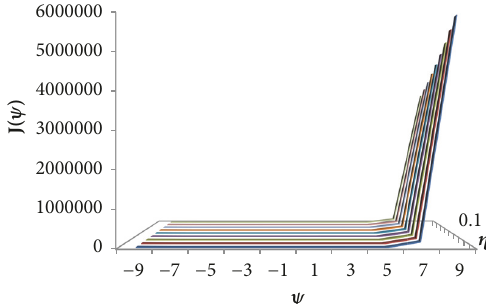
Figure 7: Graph of expected present value of the utility of asset 𝐽(𝜓) versus control 𝜓 and interest rate of liability 𝜔 while subjective discount rate 𝜂 and degree of relative risk 𝜆 are fixed at 0.1 and 0.9 , respectively.